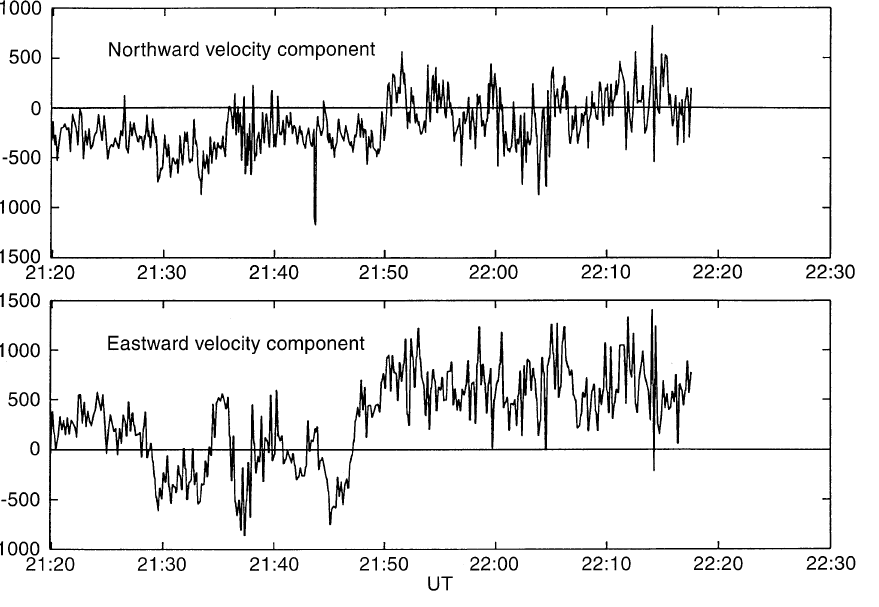
Fig. 8. Field-perpendicular convection velocities seen by EISCAT (as deduced by the tristatic radar technique). No data is available between 22 (cid:49)(cid:55) and 22 (cid:51)(cid:48)